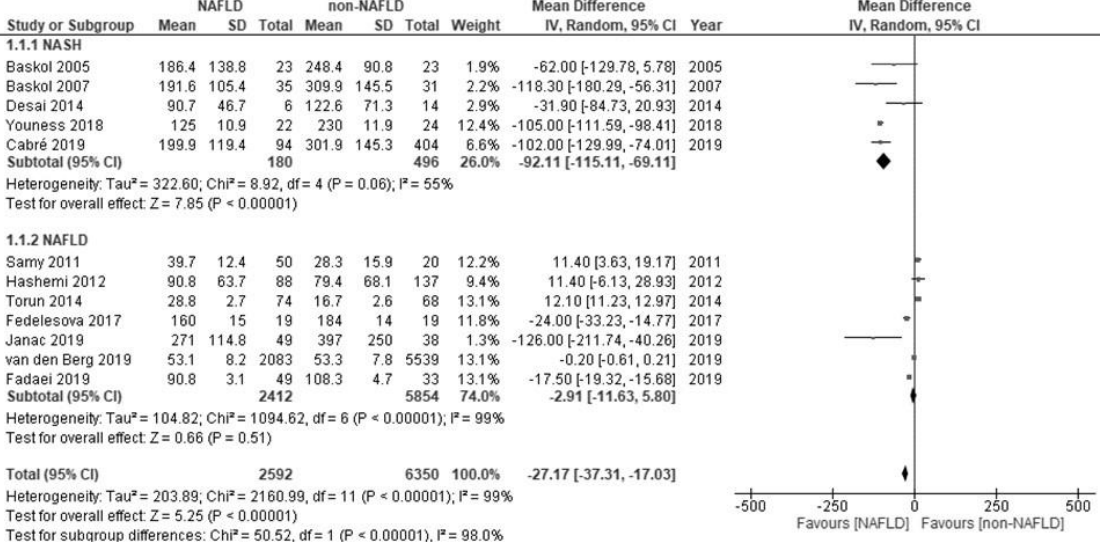
Figure 3. Forest plot of the paraoxonase activity and biopsy-proven nonalcoholic steatohepatitis (NASH; upper plot) and in nonalcoholic fatty liver disease (NAFLD), as diagnosed based on ultrasonography or laboratory data (lower plot).